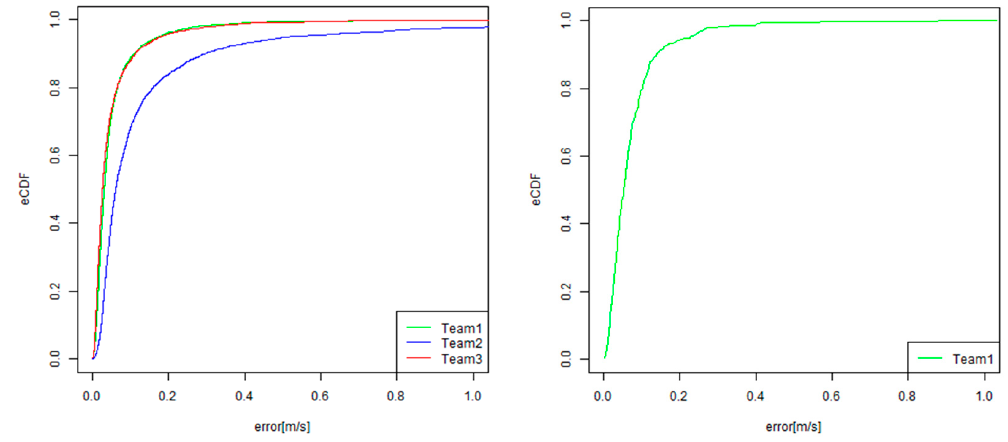
Figure 17. Results of the eCDF of the EAG ( Left : PDR track, Right : VDR track).